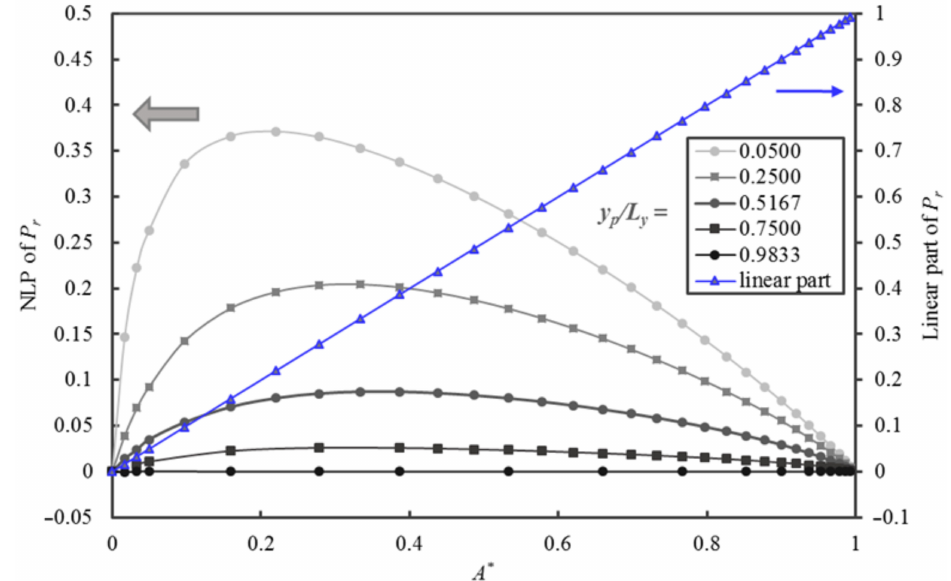
Figure 9. Plots of the linear and nonlinear portions of the P r of a MMM as a function of A * for five values of y p / L y ranging from 0.05 to